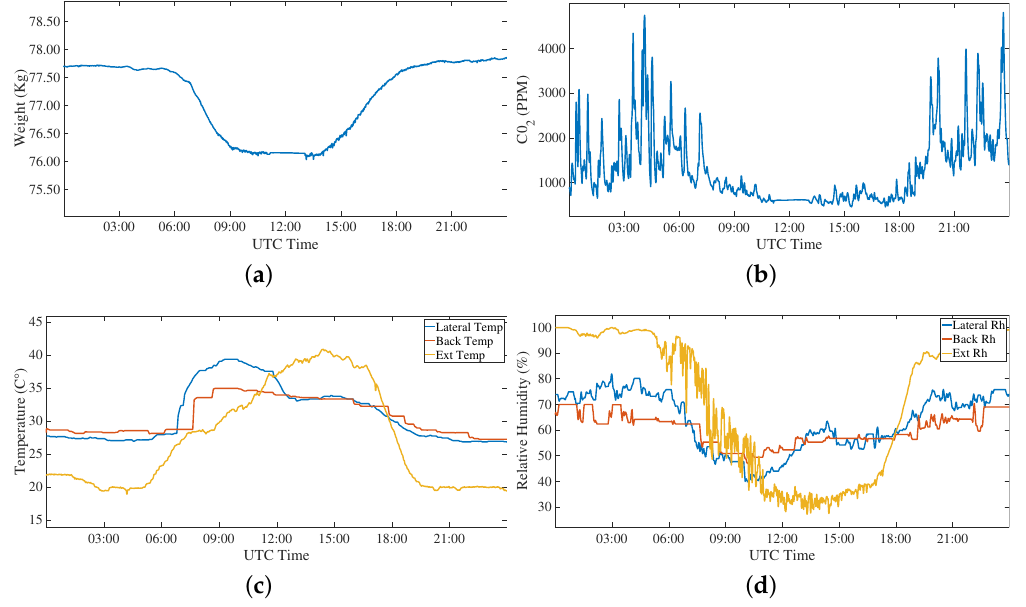
Figure 10. First event: normal activity of the bee hives monitored through the analysis of ( a ) weight, ( b ) CO 2 , ( c ) temperature, and ( d ) relative humidity variations measured over 24 h on 1 June 2018. During the spring, there is a large activity in the central part of the day confirmed by the measured